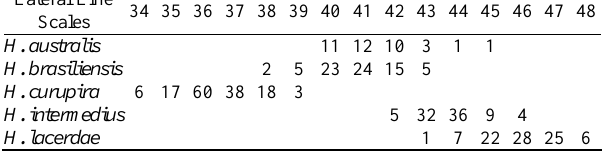
Table 2. Frequency distribution of total number of lateral line scales in species of the Hoplias lacerdae group.